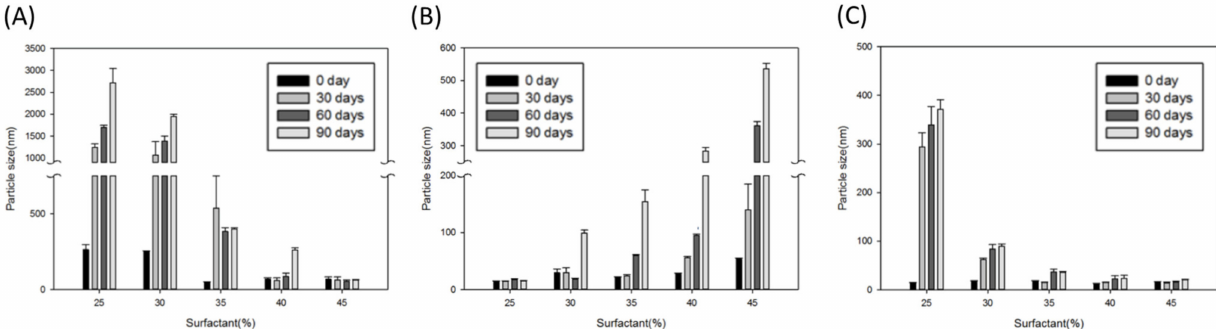
Figure 4. The particle size of microemulsions after different storage periods: ( A ) ME-20-dA; ( B ) ME-40-dA; ( C ) ME-80-dA. Data are presented as means ± SE ( n =